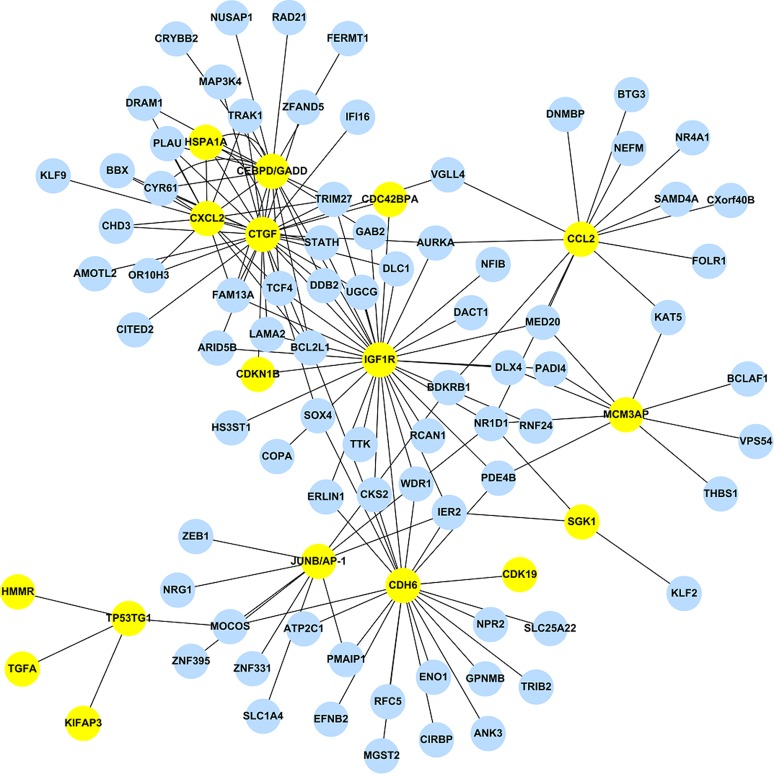
The stress-induced GAN for the 17 DEGs are shown by the yellow circles.Blue circles denoted DEGs, which were predicted by EBayes analysis.